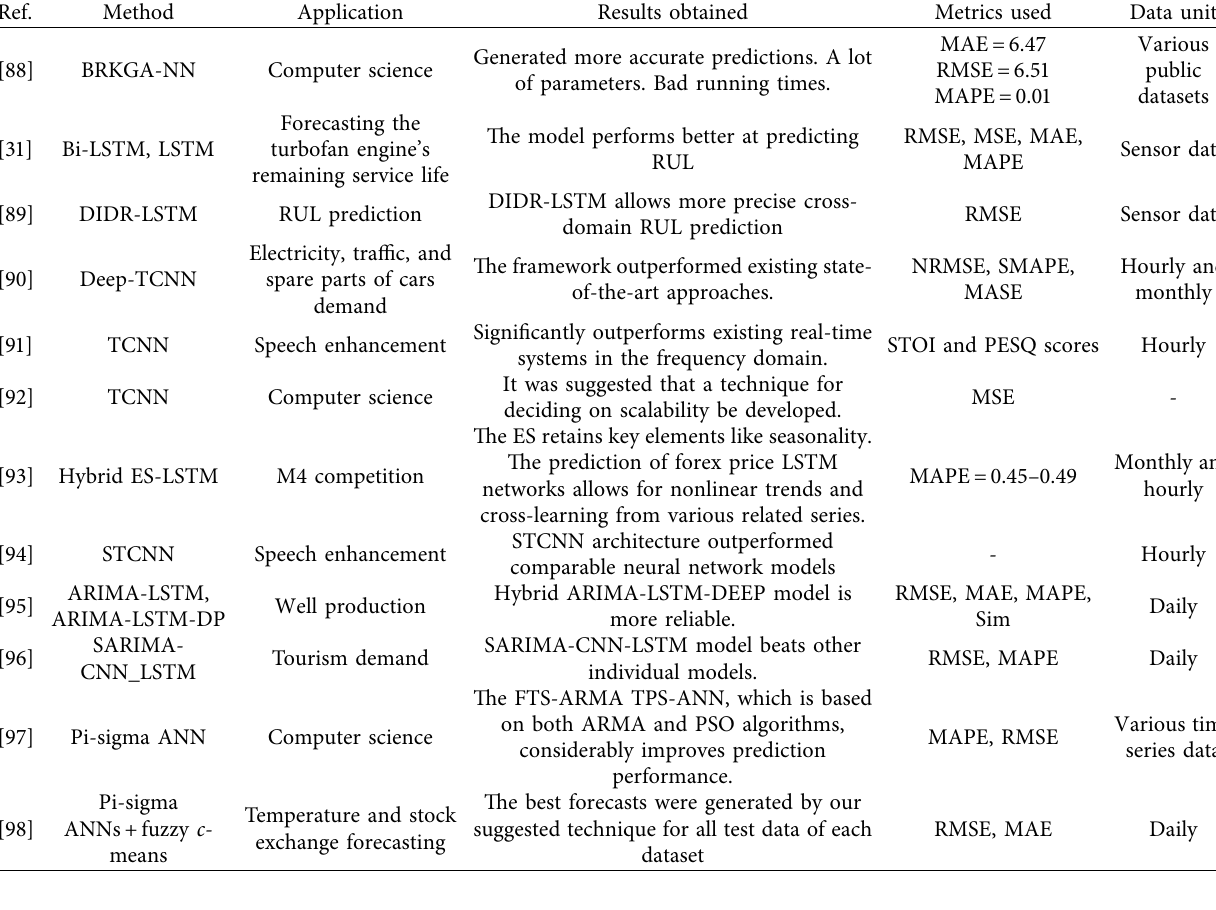
Table 7: A summary of published articles that used deep sequential models in different applications. Ref.